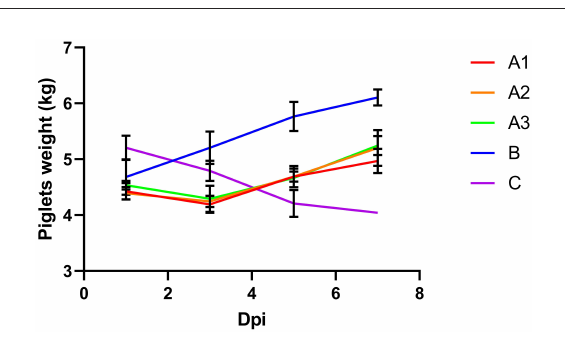
FIGURE1 After challenge, group A was treated with 5, 10 and 20g GML on day 1, 2 and 3, respectively; group B was not challenged or given drugs; group C was not given drugs after challenge, and the weight of piglets in different groups changed with time. Different colors represented different groups. The body weight of piglets in group A decreased from day 1 to day 3 and increased from day 4 to day 7. The weight of piglets in group B increased over time. The weight of piglets in group C decreased over